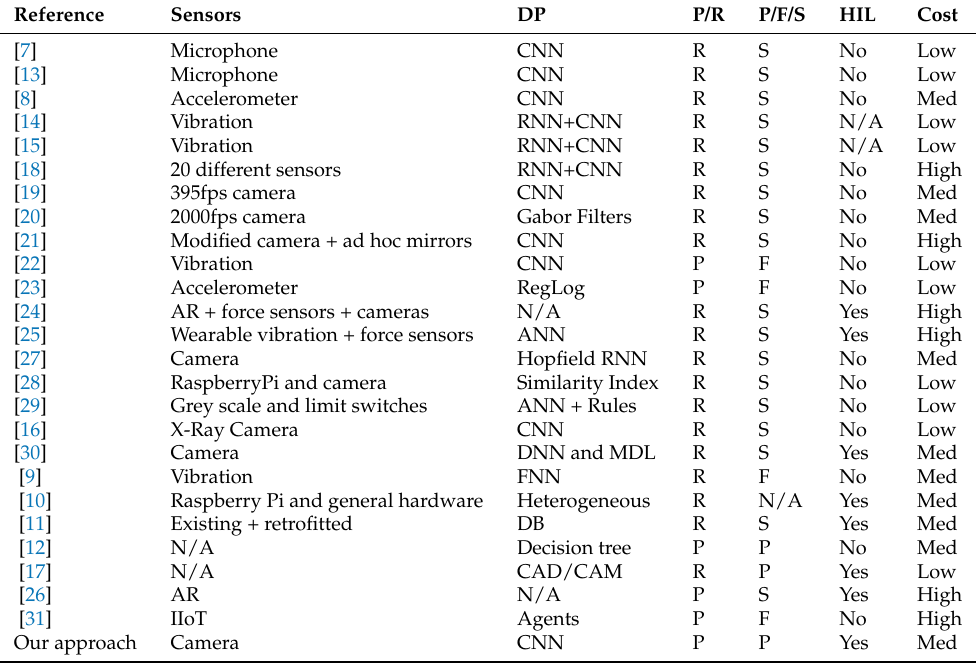
Table 1. Existing Poka Yoke approaches comparison, exploiting machine learning and computer vision in the industrial domain. DP stands for Data Processing technique, P/R for Proactive or Reactive, P/F/S for Physical, Functional and Symbolic, and HIL stands for Human-In-the-Loop.